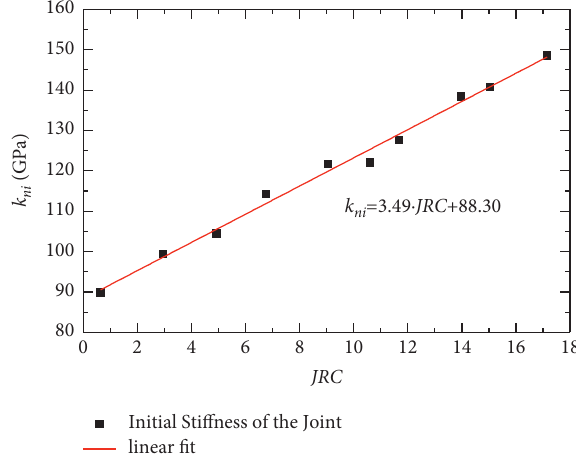
Figure 13: The relationship between the k